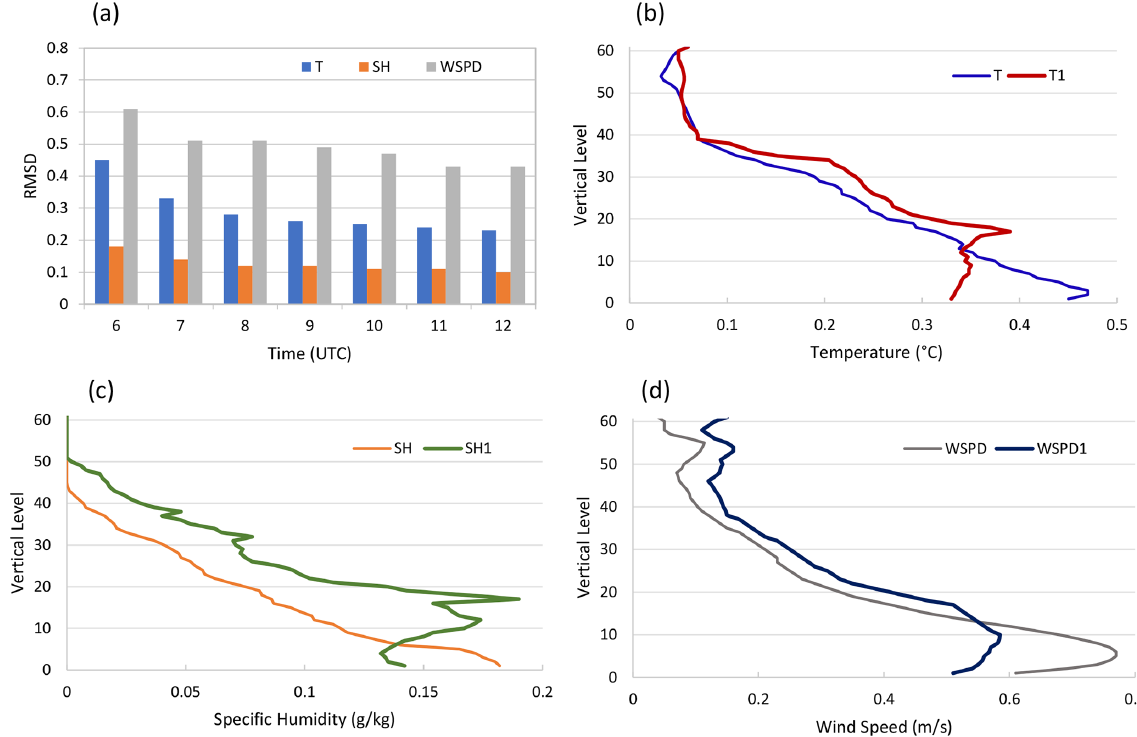
Figure 7. (a) Root mean square difference (RMSD) between DA_Mar and CTRL_Mar for 2m temperature ( ◦ C), 2m specific humidity (gkg − 1 ), and 10m horizontal wind speed (ms − 1 ), calculated over the model domain from 06:00UTC 7 March to 12:00UTC 7 March 2018, and vertical profiles of RMSD for (b) temperature, (c) specific humidity, and (d) wind speed at 06:00UTC ( T , SH, and WSPD) and 07:00UTC ( T 1, SH1, and WSPD1) 7 March 2018. Table 2. Root mean square error (RMSE) for 2m temperature ( ◦ C) forecast over South Korea for difference experiments. Time (mm/dd/yyyy) CTRL_Mar DA_Mar Time (mm/dd/yyyy) CTRL_Feb DA_Feb 12:00UTC